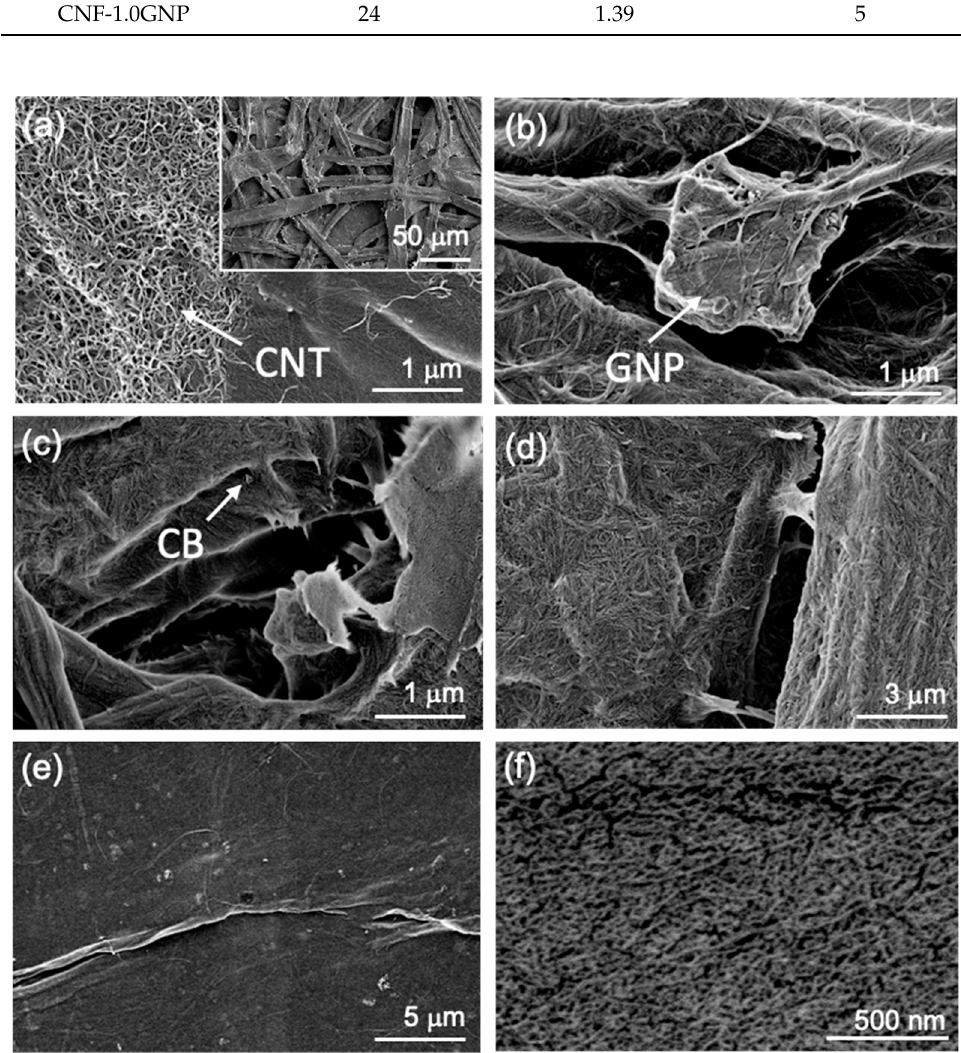
Figure 4. Microstructure of the nanocomposite films. SEM images of CP-0.2%CNT (inset at low magnification) ( a ), CP-0.3%GNP ( b ), MCC-0.1%CB ( c ), MCC-0.2%CNT ( d ), CNF-0.3%CB ( e ) and CNF-0.4%CNT ( f ). Table 1. Textural properties of nanocomposite films.